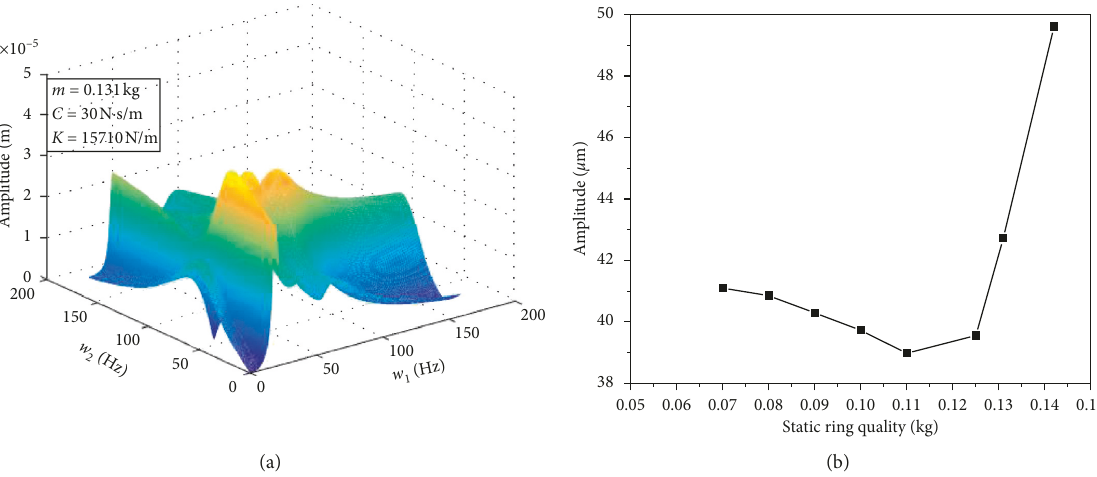
Figure 5: Quality impact on the output spectrum. (a) Nonlinear output spectrum with m � 0.131kg. (b) Relationship between quality and response